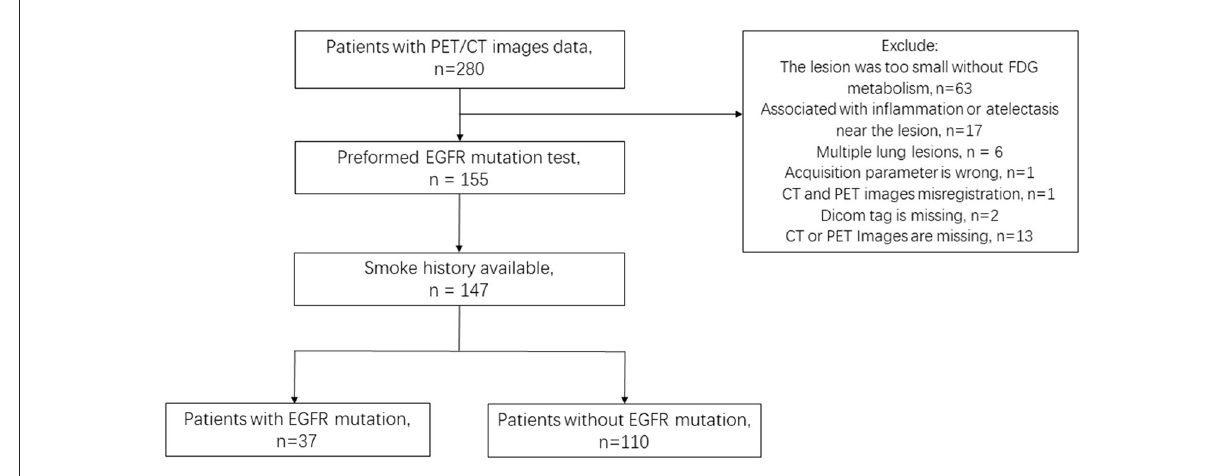
FIGURE1 Flowchart of patient selection. EGFR, epidermal growth factor receptor.